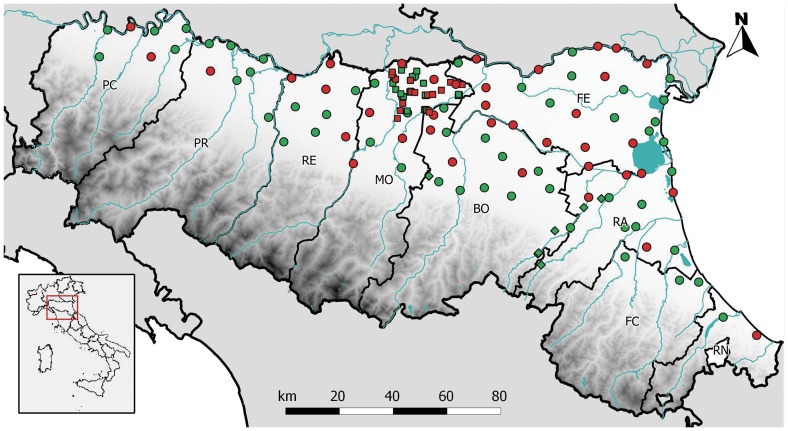
Emilia-Romagna regional map with mosquito sampling stations and locations of USUV-positive pools.Circle, plan trap; square, Modena trap; diamond, extra-plan trap; red, USUV-positive station; green, negative station. Province abbreviations: PC, Piacenza; PR, Parma; RE, Reggio Emilia; MO, Modena; BO, Bologna; FE, Ferrara; RA, Ravenna; FC, Forlı ` Cesena; RN, Rimini.